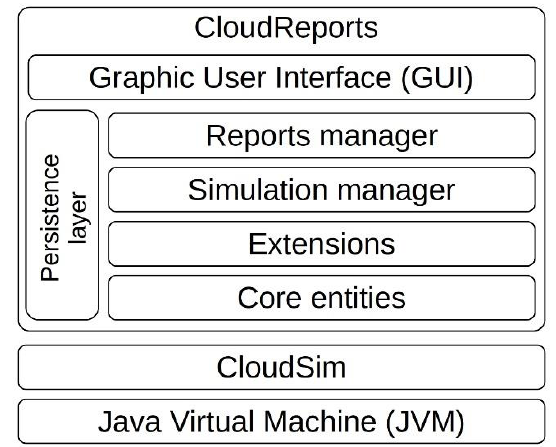
Figure 5. CloudReports Architecture and its layers [14].